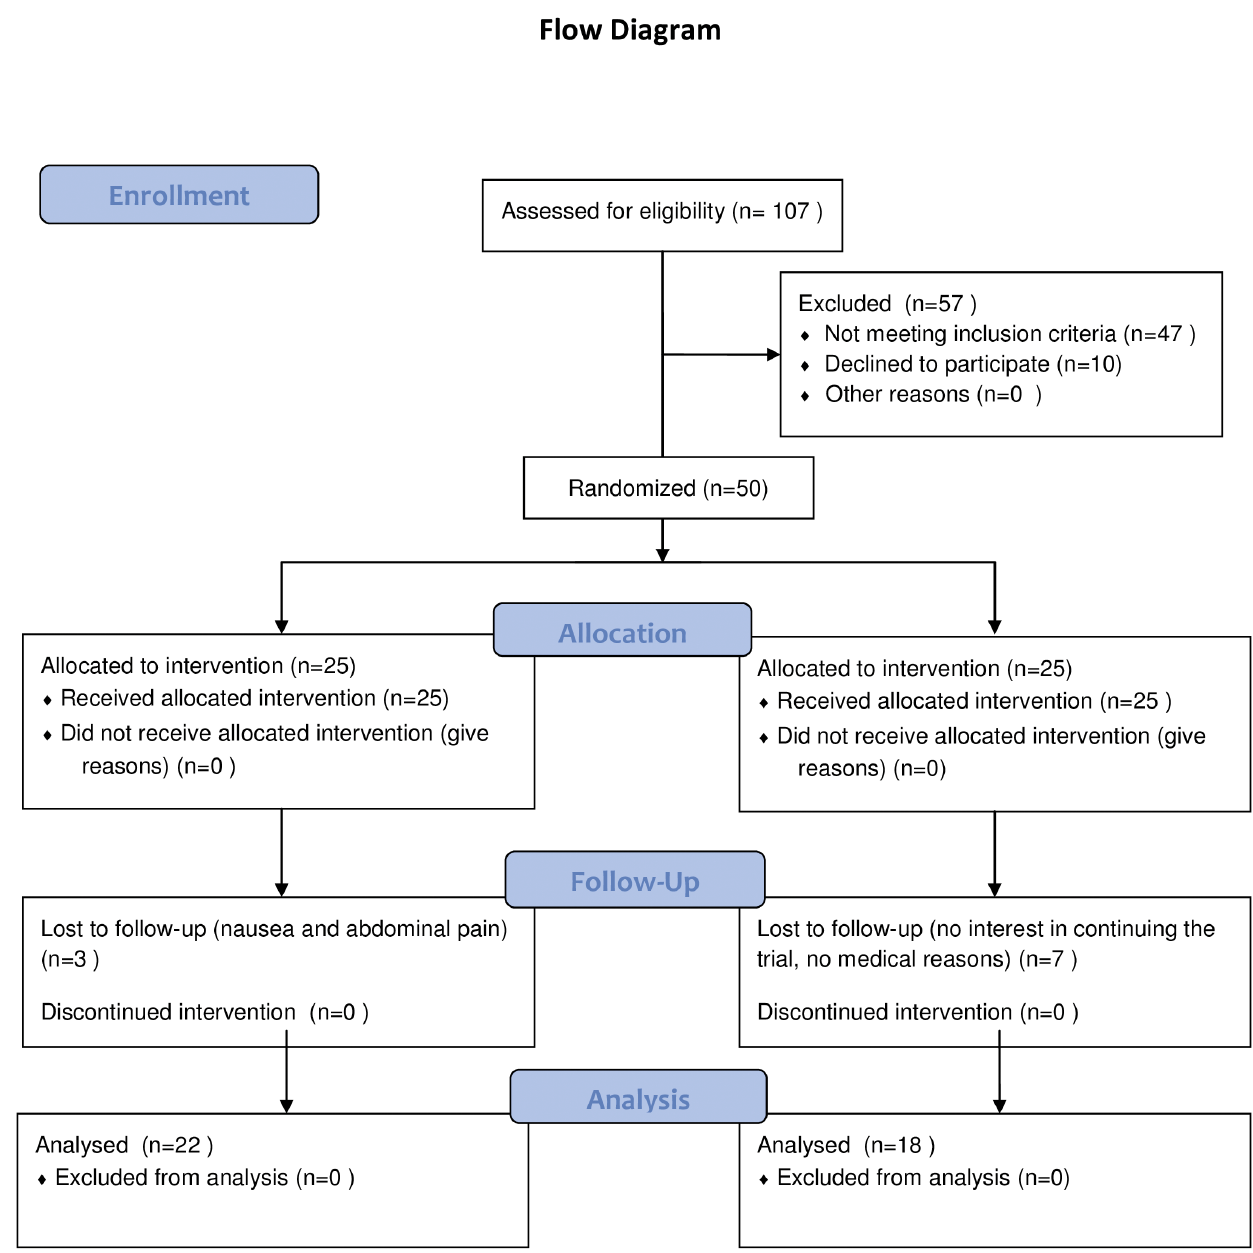
Figure 1. Flow diagram demonstrating participants flow through the study.